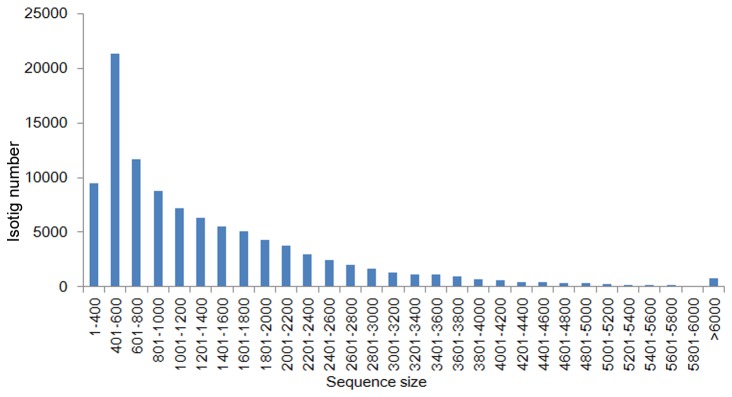
Isotig length distribution.The x-axis represents the sequence length in base pairs. The y-axis represents the number of isotigs relative to the sequence length.